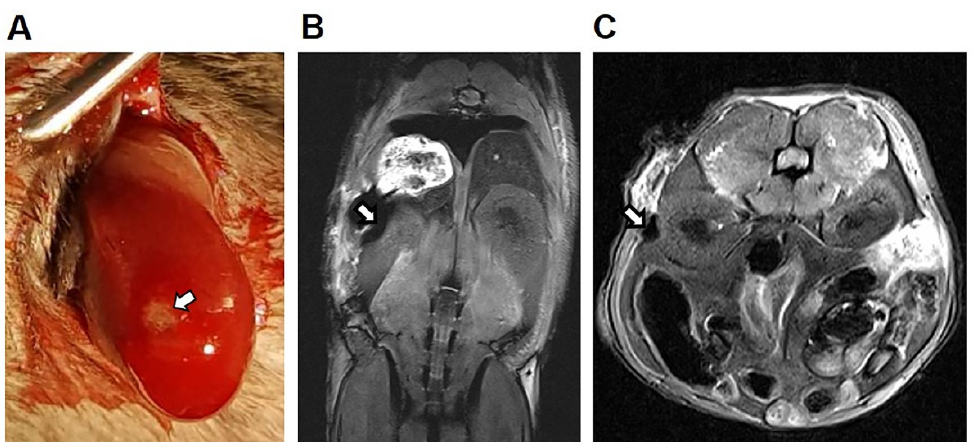
Figure 7. In vivo MR image of the MnMEIO-Ex4 NPs-labeled islet graft on the second day of transplantation. ( A ) Three hundred MnMEIO-Ex4 NPs-labeled islets were transplanted under the left kidney capsule of a C57BL/6 mouse. The recipient was scanned by a 7.0 T MRI system with coronal ( B ) and transverse ( C ) sections on the second day of transplantation. The graft was indicated by arrows.